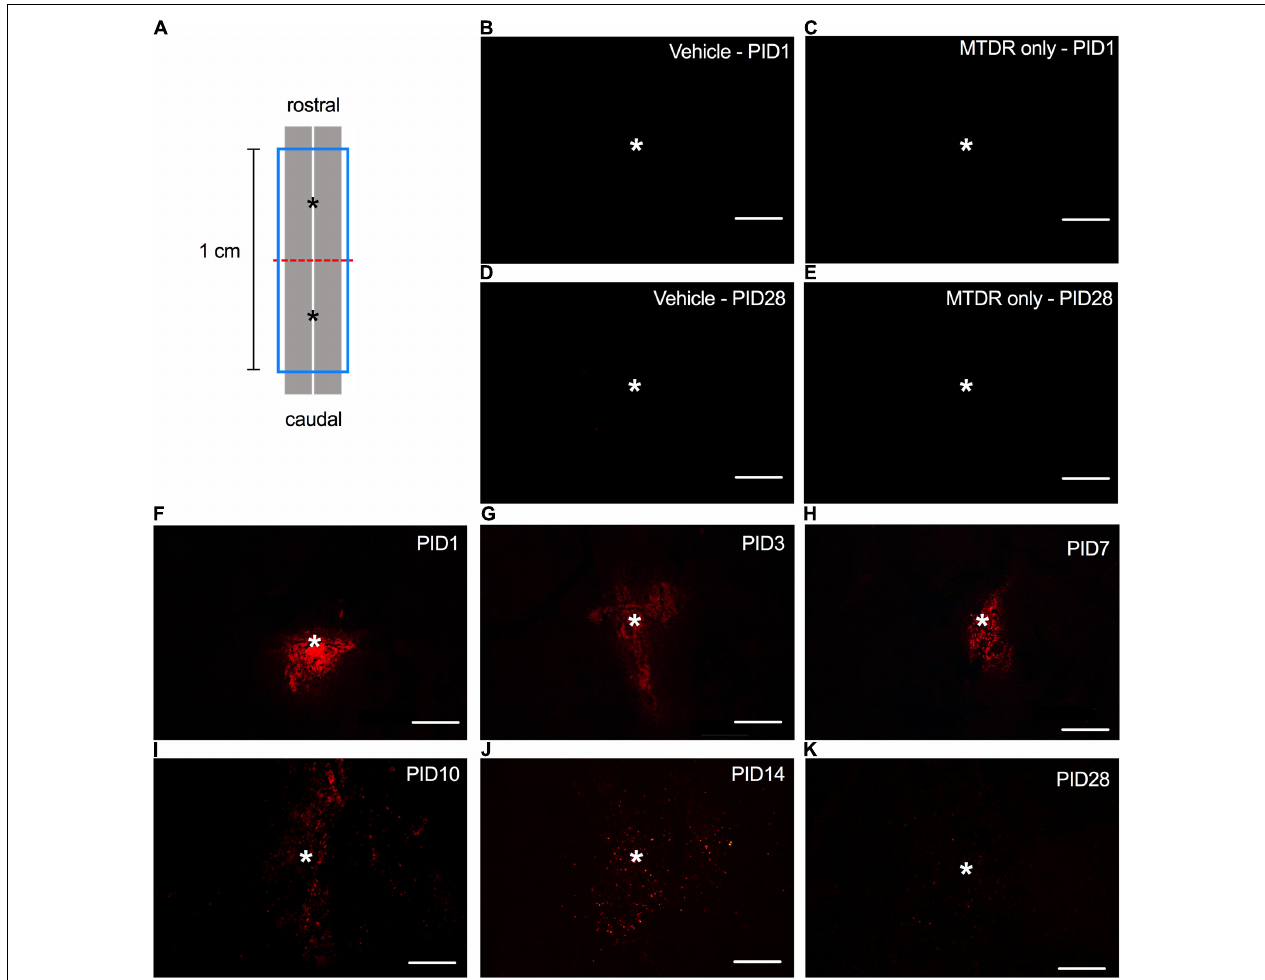
FIGURE 1 | The spatiotemporal distribution of transplanted mitochondria in the injured spinal cord of rats with traumatic SCI. (A) Diagram of the schematic spinal cord. The red dash line indicated the injury site. The blue frame indicated the 1-cm sampling area. The asterisks denoted the sites of administration of allogeneic mitochondria. (B) Representative micrograph of MTDR signals in the injured spinal cord of rat injected with 1x PBS vehicle on PID 1. (C) Representative micrograph of MTDR signals in the injured spinal cord of rat injected with MTDR dye on PID 1. (D) Representative micrograph of MTDR signals in the injured spinal cord of rat injected with 1x PBS vehicle on PID 28. (E) Representative micrograph of MTDR signals in the injured spinal cord of rat injected with MTDR dye on PID 28. (F–K) Representative micrograph of MTDR signals which were detected on PID1, 3, 7, 10, 14, and 28 in the injured spinal cord of rats injected with MTDR-labeled mitochondria. Horizontal sections were used. Scale bar = 100 µ m. N = 1 rat per panel. The asterisks indicate the points of injection.